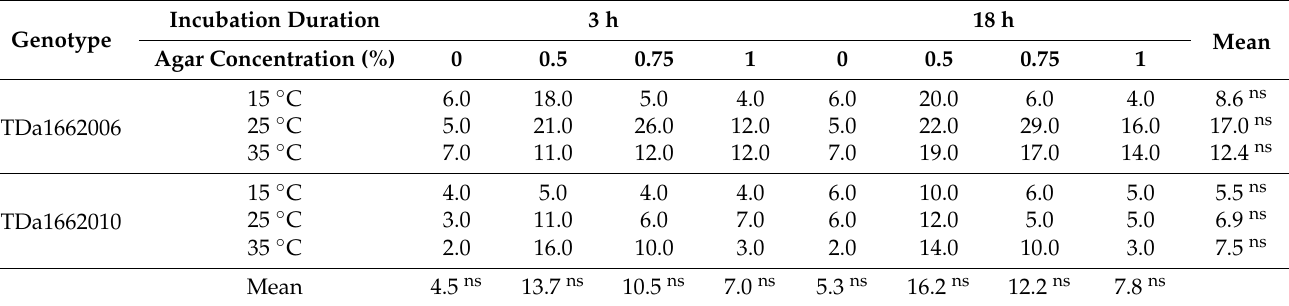
Table 2. Effects of the interactions between the incubation duration and temperature and the agar concentration on percentage germination of pollen from two D. alata genotypes.